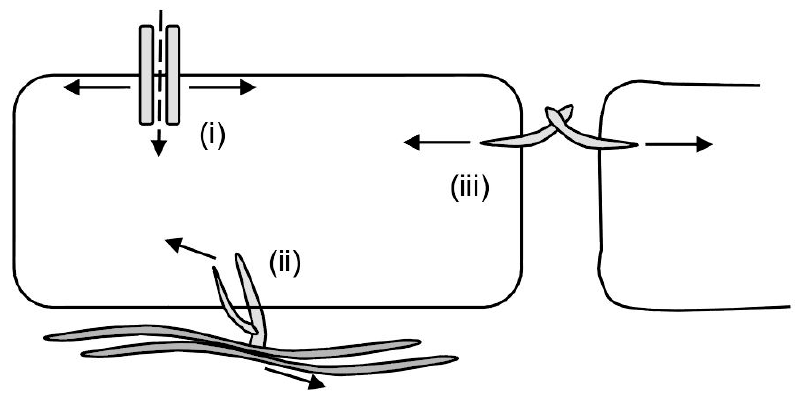
Figure 1. Three representative modes of mechanosensing by cells. Cells can use ( i ) mechanosensitive ion channels and receptors; ( ii ) mechanosensitive cell-ECM (extracellular matrix) interactions; and ( iii ) mechanosensitive cell-cell interactions. Solid arrows indicate forces acting on the mechanosensitive elements and the dashed arrow indicates ion conduction.